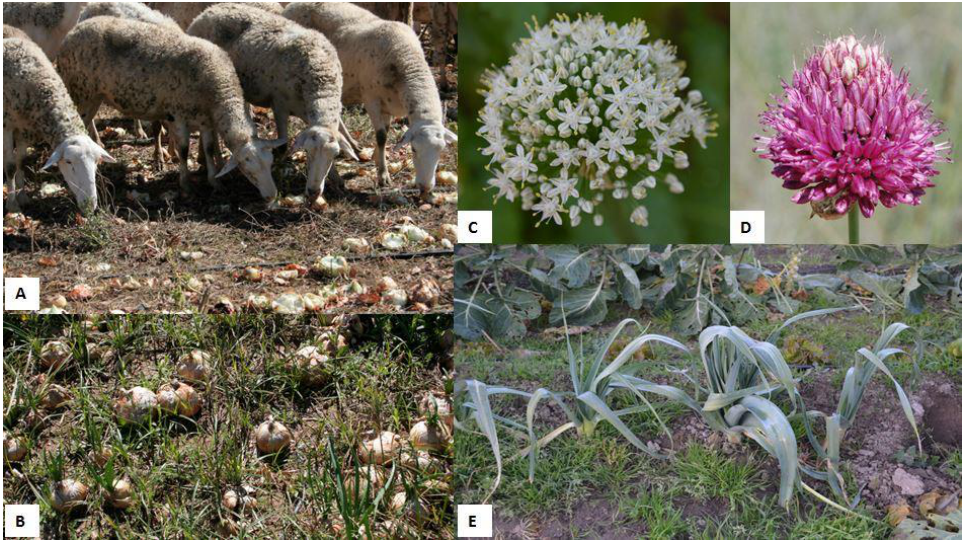
Figure 2. ( A ) A sheep herd grazing on an onion ( Allium cepa ) field. ( B ) Onion ( A. cepa ) field ready to harvest. ( C ) Characteristic umbel of white flowers of an onion ( A. cepa ). ( D ) Umbel of pink flowers of a round-headed leek ( A. sphaerocephalon ). ( E ) Leeks ( A. ameloprasum var. porrum ).